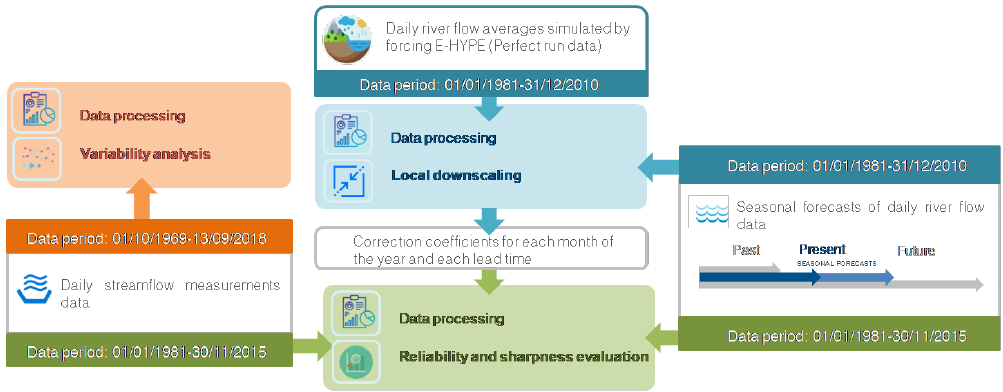
Figure 2. Flowchart of the different methodologies applied in this work (variability analysis, local downscaling, reliability and sharpness evaluation) and the data sources used, showing the study periods available for each method.